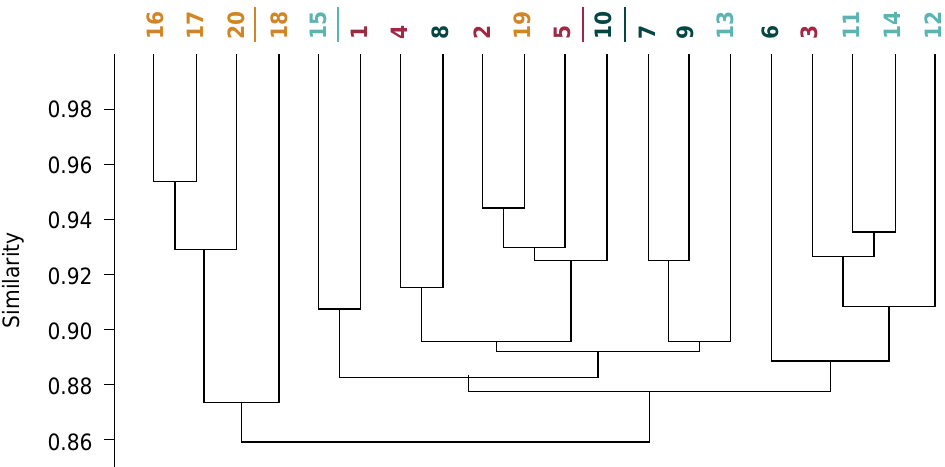
Figure 7. Dendrogram of similarity obtained by Bray-Curtis, showing the similarity of the sample according to the relative contribution of the SEM-EDS and PSD data. Note: Red samples – Santa Cândida, Green samples – Guarani, Blue samples – Guaraituba, Yellow samples – Boa Vista, neighborhoods from Curitiba and Colombo, Paraná (Table 1); samples underlined refer to the suspect sample for each